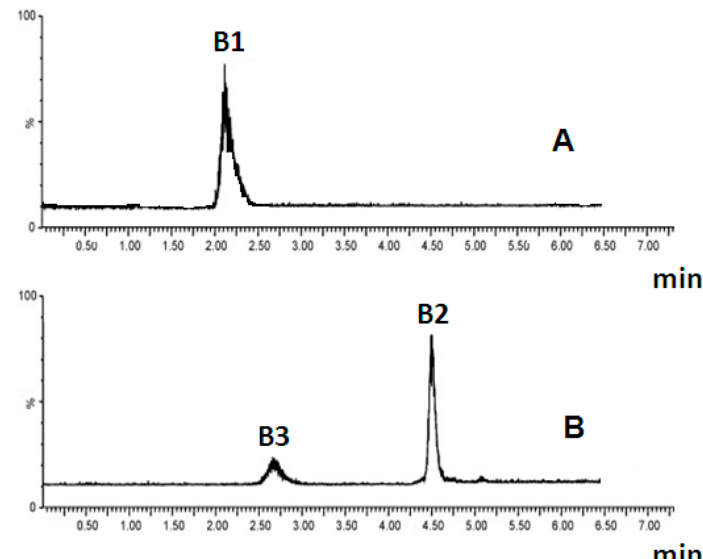
Figure 1. LC-MS/MS chromatogram of a naturally contaminated sample with FB1, FB2 and